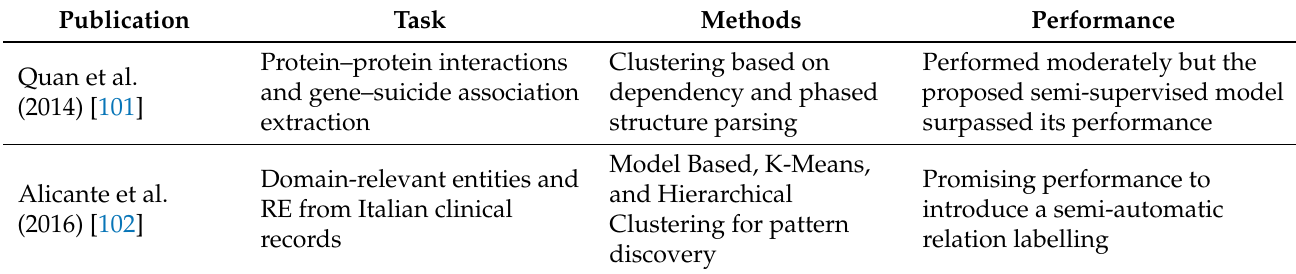
Table A6. Summary of the unsupervised learning approaches for clinical